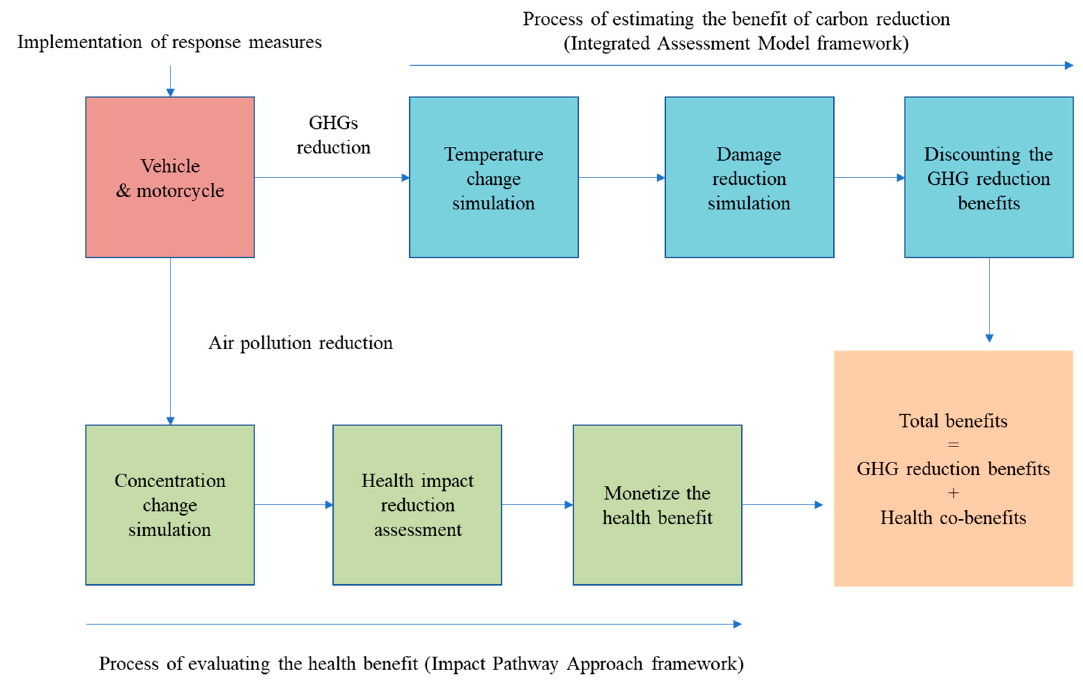
Figure 1. Conceptual framework for monetizing greenhouse gas (GHG) reduction benefits and health co-benefits.